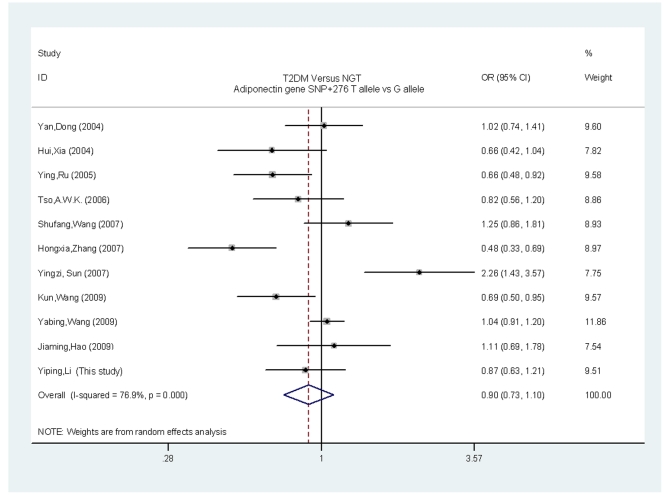
Individual and pooled ORs and 95% CI for SNP+276 (T vs.G) for all studies.